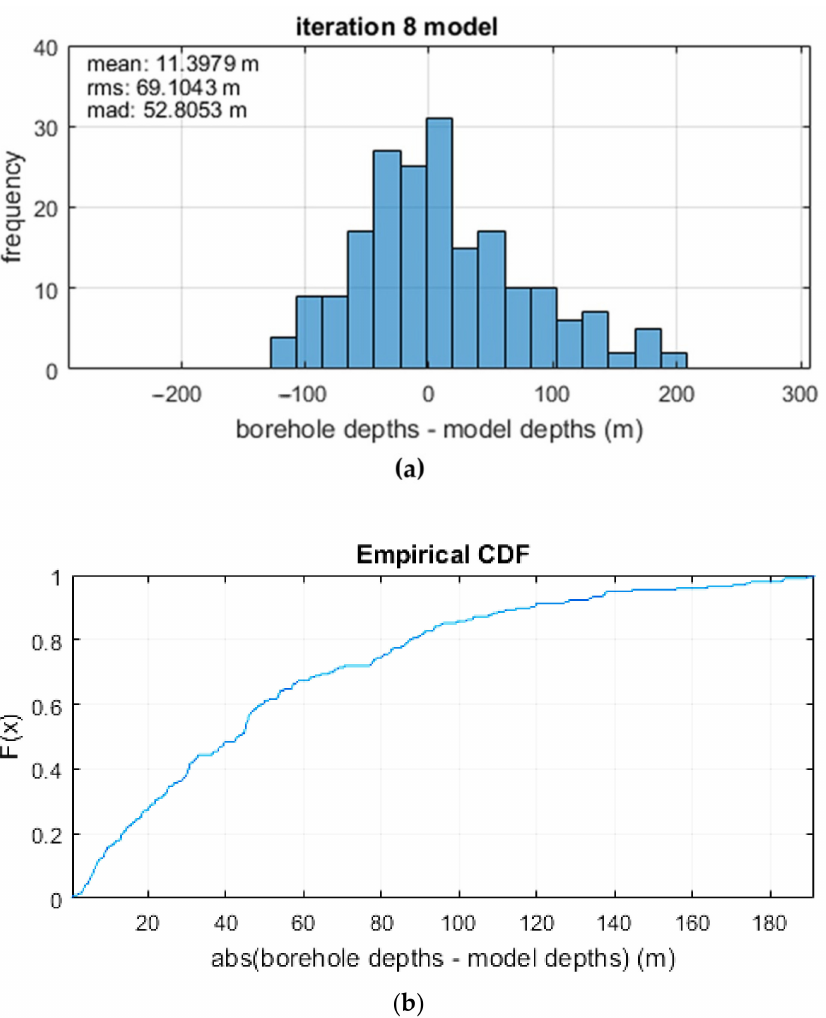
Figure 8. ITRESC basement model. ( a ) Histogram of the difference between the depth to constraints and the ITRESC basement depth at the same locations. ( b ) Empirical cumulative distribution function of the modulus of the difference between the constraints’ depth and model